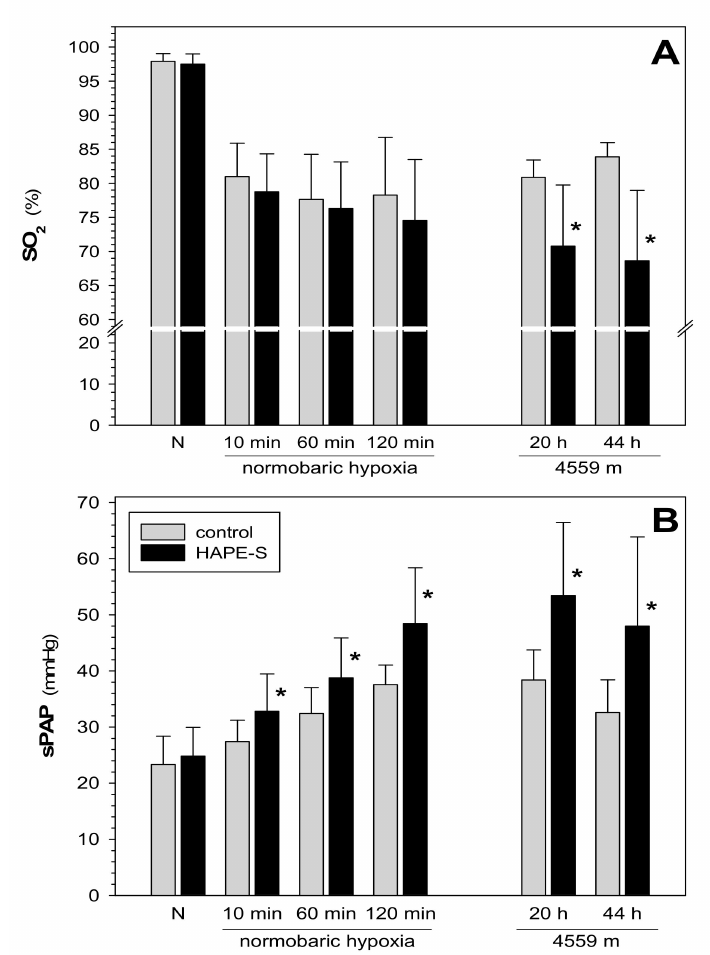
Figure 3. Time course of change in SO 2 ( A ) and sPAP ( B ) in controls and HAPE-susceptibles (HAPE-S) during normobaric hypoxia (0–2 h) and at the Capanna Margherita (4559 m). Data on short-term normobaric hypoxia are from 15 controls and 17 HAPE-S from the study reported in [17], those from exposure to high-altitude (4559 m) are from 10 controls and 9 HAPE-S from reference [2]. In both studies, systolic pulmonary arterial pressure (sPAP) has been measured by Doppler echo-cardiography. Oxygen saturation (SO 2 ) was measured by pulse-oximetry. Mean values ± standard deviation; N: normoxia; * indicates di ff erence between controls and